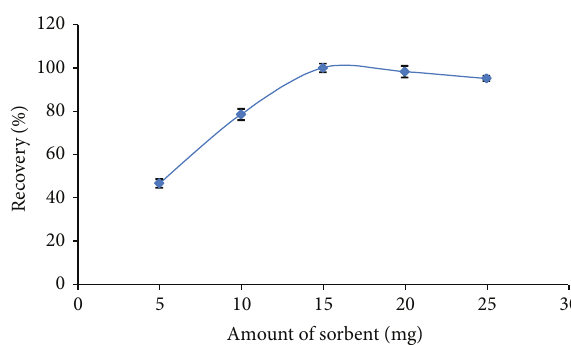
Figure 7: Effect of amount of sorbent on the recovery of